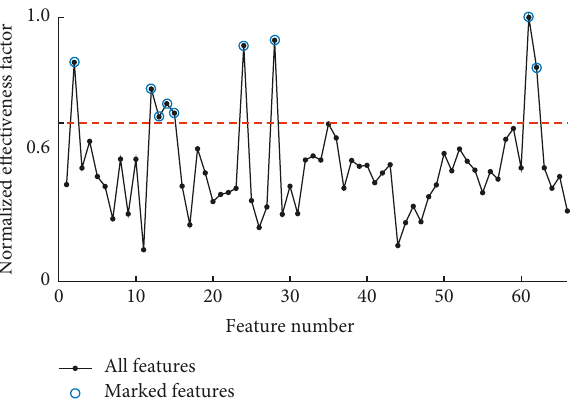
Figure 20: The marked features of IMFs components derived from EEMD decomposition.